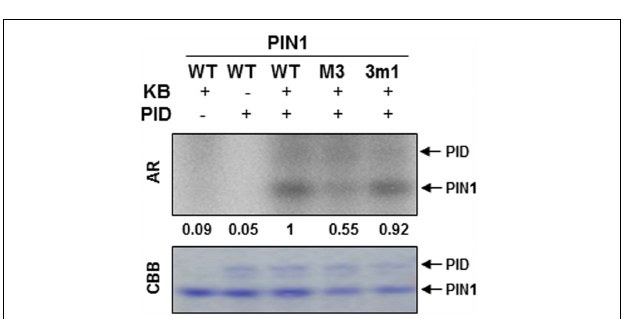
FIGURE 7 | In vitro phosphorylation assay of the hydrophilic loop (HL) of PIN1. Autoradiogram (AR) of PIN1-HL phosphorylation assay. Wild-type (WT), M3, and 3m1 PIN1-HL proteins were analyzed for phosphorylation by PID kinase using [ γ − 32 P] ATP as phosphate source. KB, kinase buffer; CBB, Coomassie Brilliant Blue-stained gel. The numbers below AR indicate relative phosphorylation intensities of PIN1 that were normalized by the PIN1 band intensities in